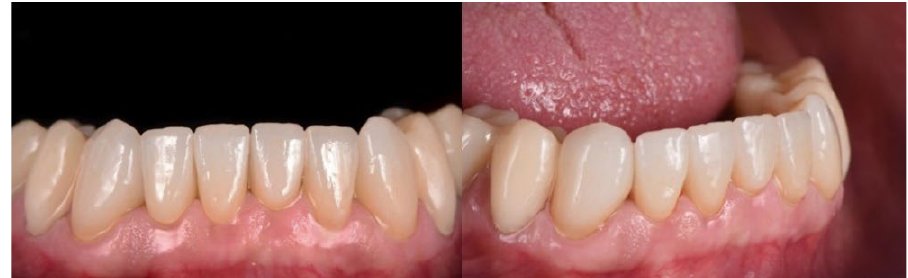
Figure 3. The LCM-manufactured lithium disilicate restorations in situ. In order to assess the marginal adaptation on the dyes, all six restorations in situ were scanned again with an IOS. Furthermore, the interior surface of each single restoration was scanned with a laboratory scanner (D2000, 3 Shape, Copenhagen, Denmark). The single scans of each restoration were matched with the scan of the same restorations in situ in the metrical software (Geomagic Control X, 3D Systems, Morrisville, NC, USA) using the best fit function (Figure 4A). The teeth preparation scan was also aligned with the scan of restorations in situ (Figure 4B). The marginal and bottom adaptation of the LCM-printed restorations were assessed according to the distance between the interior surface of each restoration and preparation surface of the corresponding dye (Figure 4C).